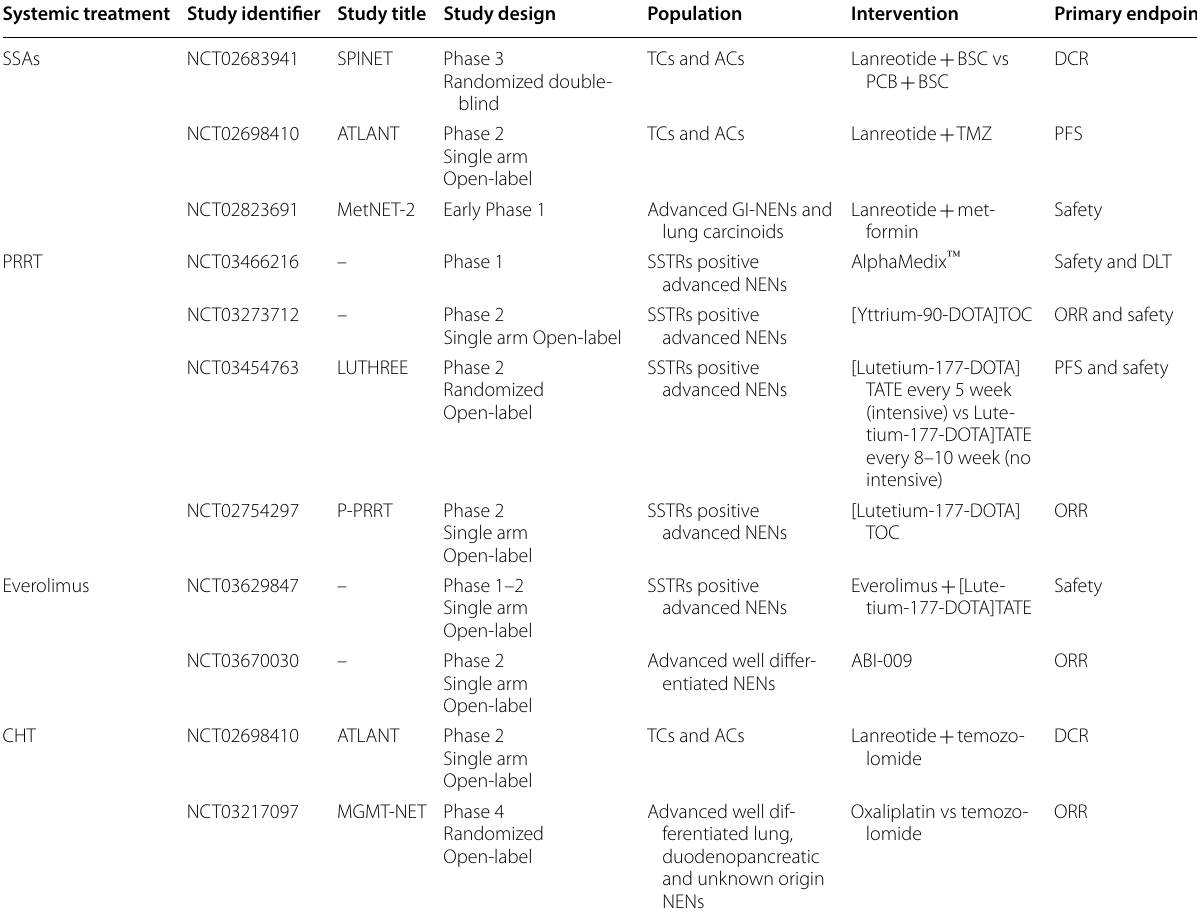
TCs typical carcinoids, ACs atypical carcinoids, PCB placebo, BSC best supportive care, TMZ temozolomide, DCR disease control rate, PFS progression free survival, GI gastrointestinal, SSTRs somatostatin receptors, ORR objective response rate, CHT chemotherapy